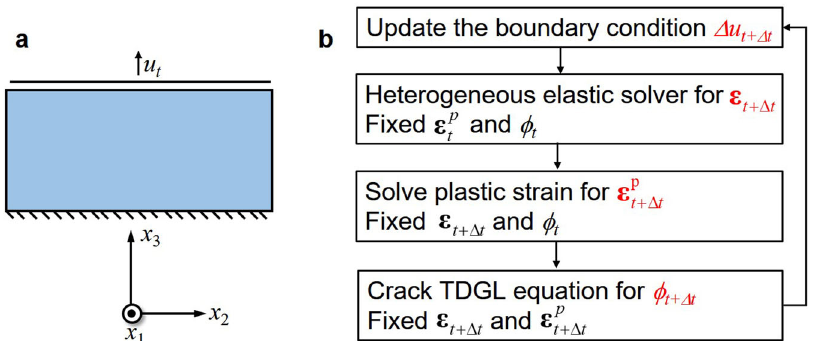
Fig. 2 Illustrations for numerical implementation. a Schematic for the mechanical boundary conditions. b Flowchart for the staggered scheme with the updated variables marked in